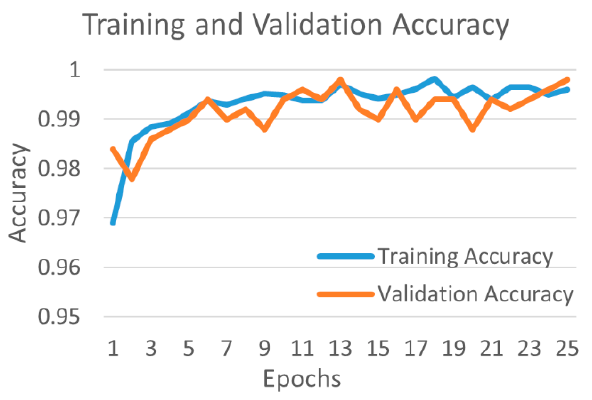
Figure 7. Training and validation accuracy of best performing NasnetMobile model for COVID-19 and viral pneumonia class.